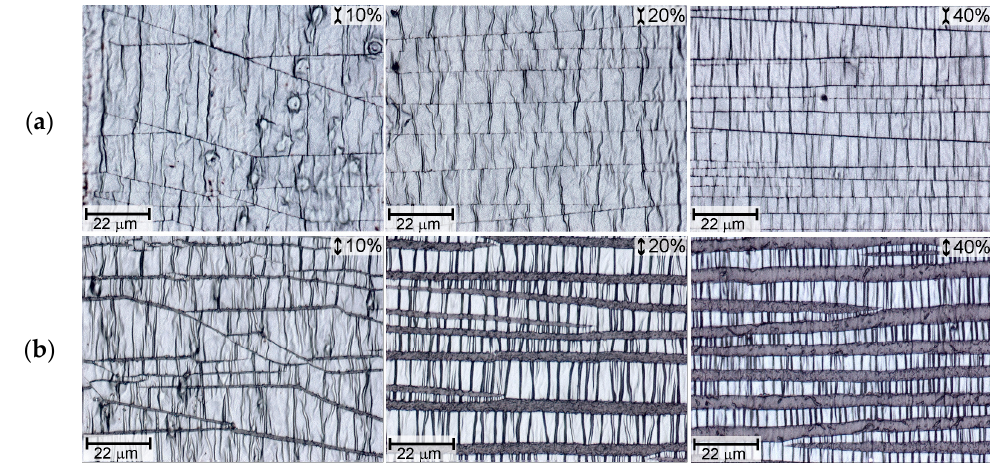
Figure 2. Optical images of PU after PIII 3-17 and fatigue loading ( ε = 10%, 20%, 40%) in the unloaded ( a ) and stretched ( b ) states. The strain direction is vertical.